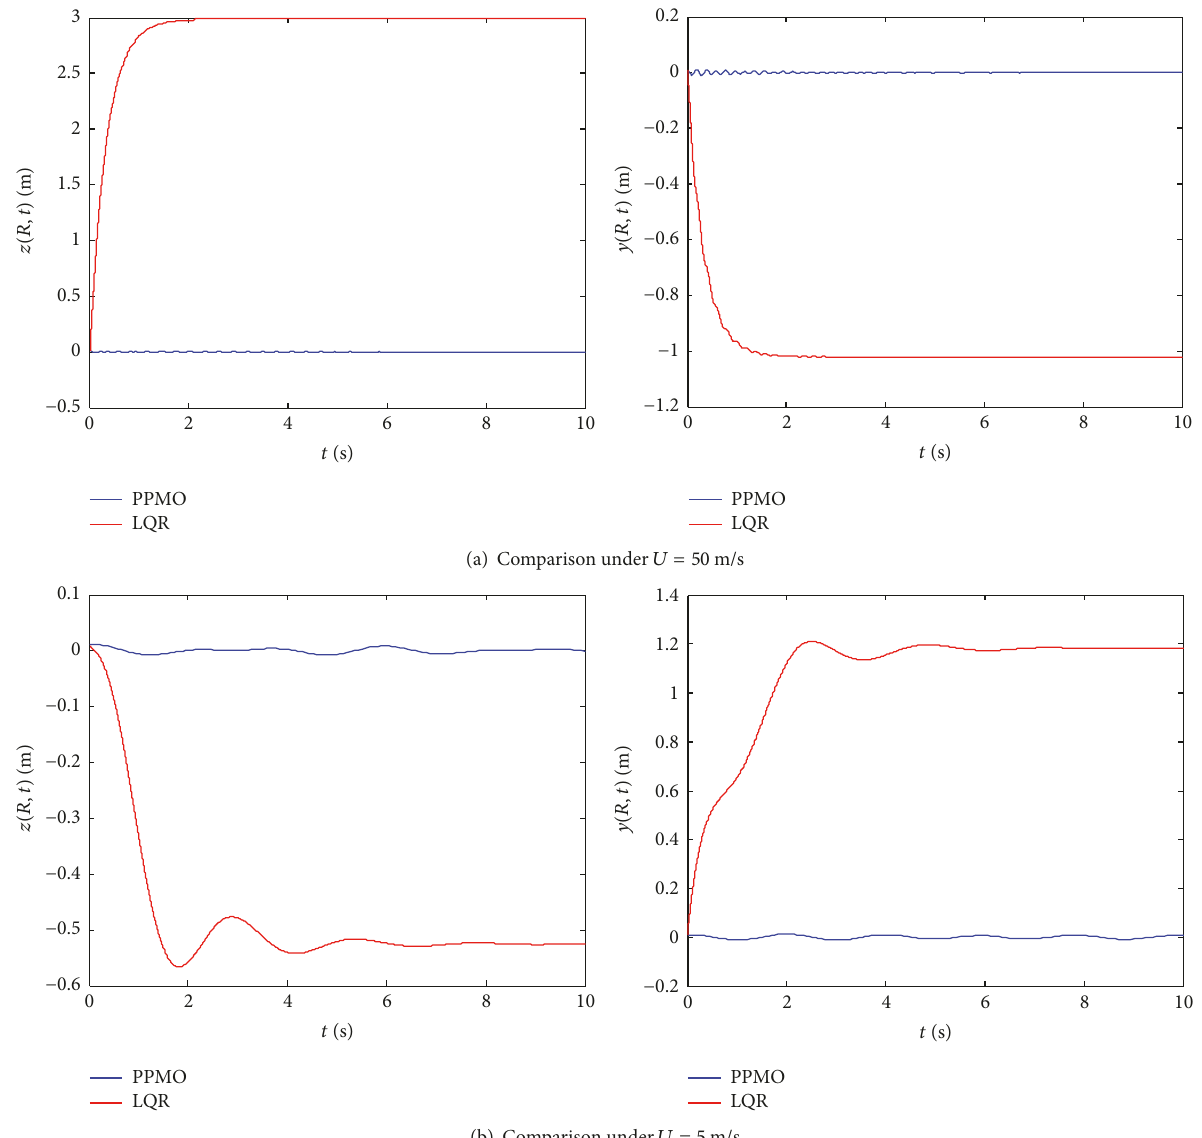
Figure 7: Comparisons of control effects between PPMO and LQR under conditions of wind speeds of 𝑈 = 50 m/s (a) and 𝑈 = 5 m/s (b),